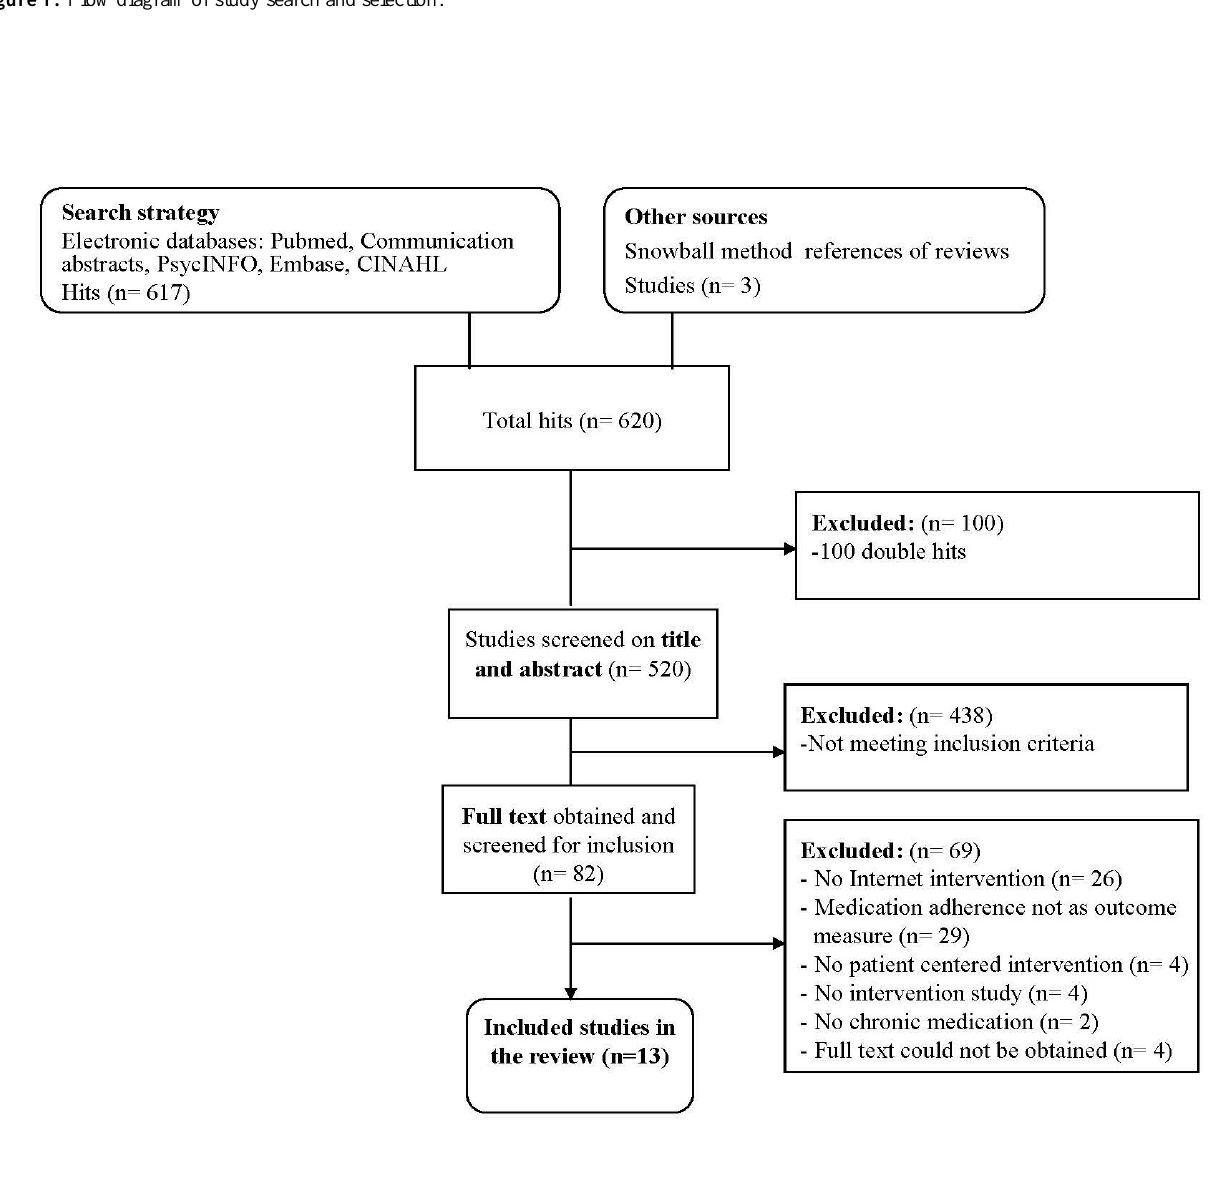
Figure 1. Flow diagram of study search and